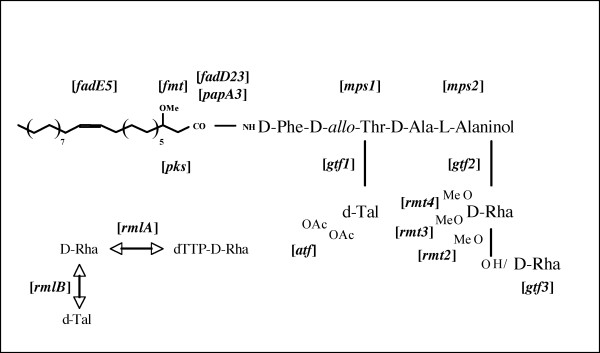
Schematic representation of the structure of the GPLs from M. smegmatis. The genes involved in the various metabolic steps are indicated in brackets. The locations of the variable substitutions linked to the common GPL core are shown. OAc: acetyl, OMe, methyl. dTal, 6-deoxytalose, D-Rha, rhamnose of the D series.